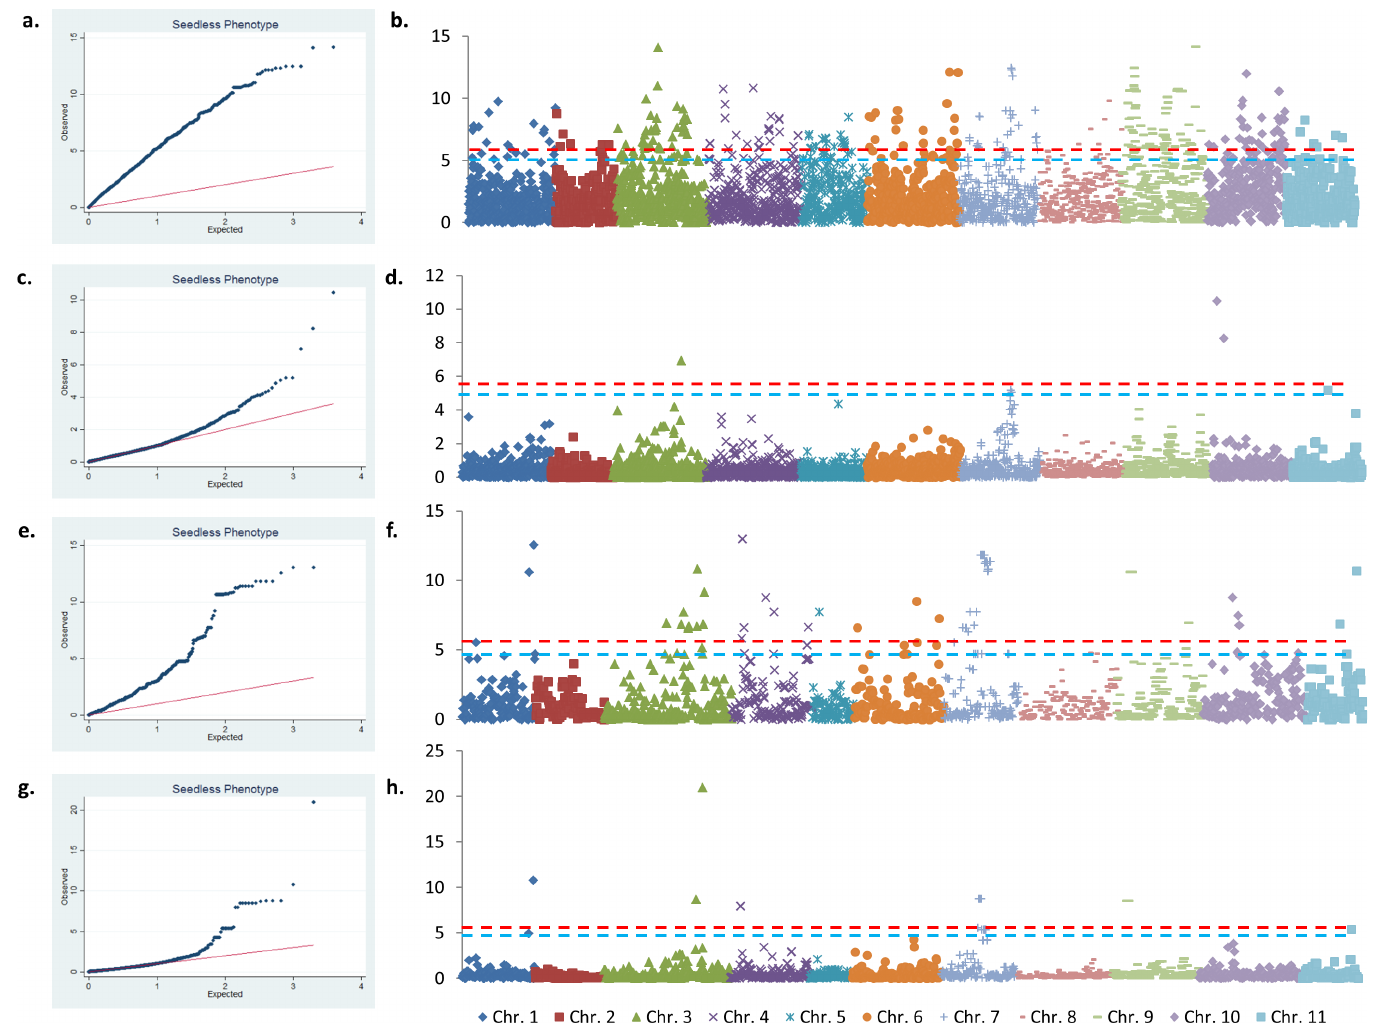
Fig 4. GWAS for the seedless phenotype (MAF > 10%). Quantile-Quantile plots and corresponding Manhattan plots obtained on the Panel using simple GLM (a-b) and uncompressed MLM K + Q (k = 4) (c-d) and the Papuan Subset using simple GLM (e-h) and uncompressed MLM K (g-h). Colored dashed lines correspond to Bonferroni corrected thresholds of p = 0.05 (blue) and p = 0.01